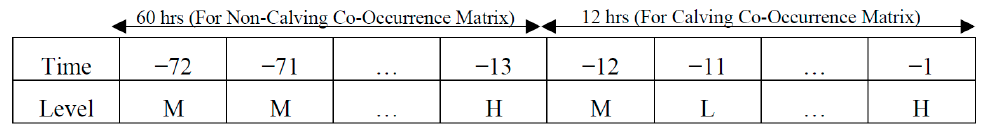
Figure 4. Sequence of Activity Level.